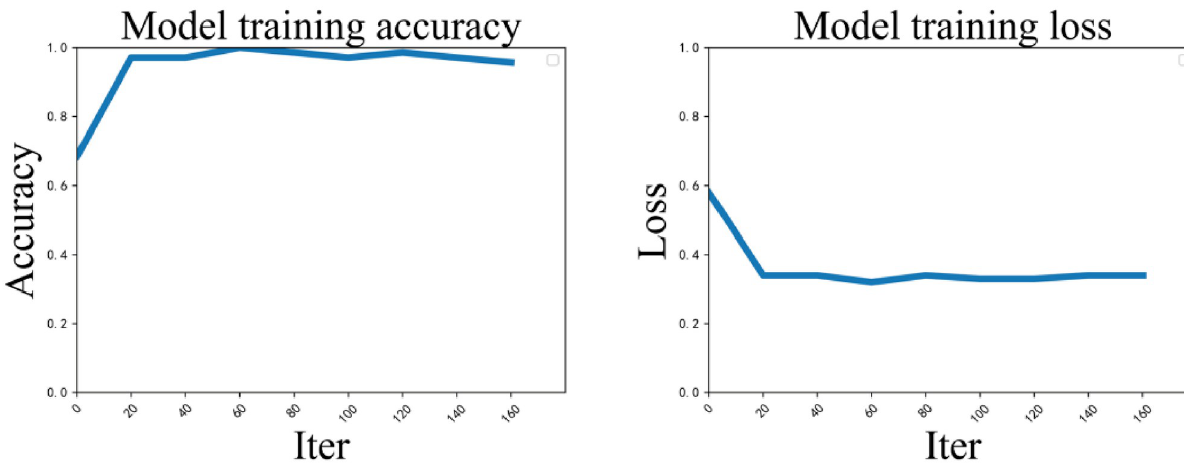
Fig 4. Accuracy and loss curves of the model when trained on the Twitter dataset.